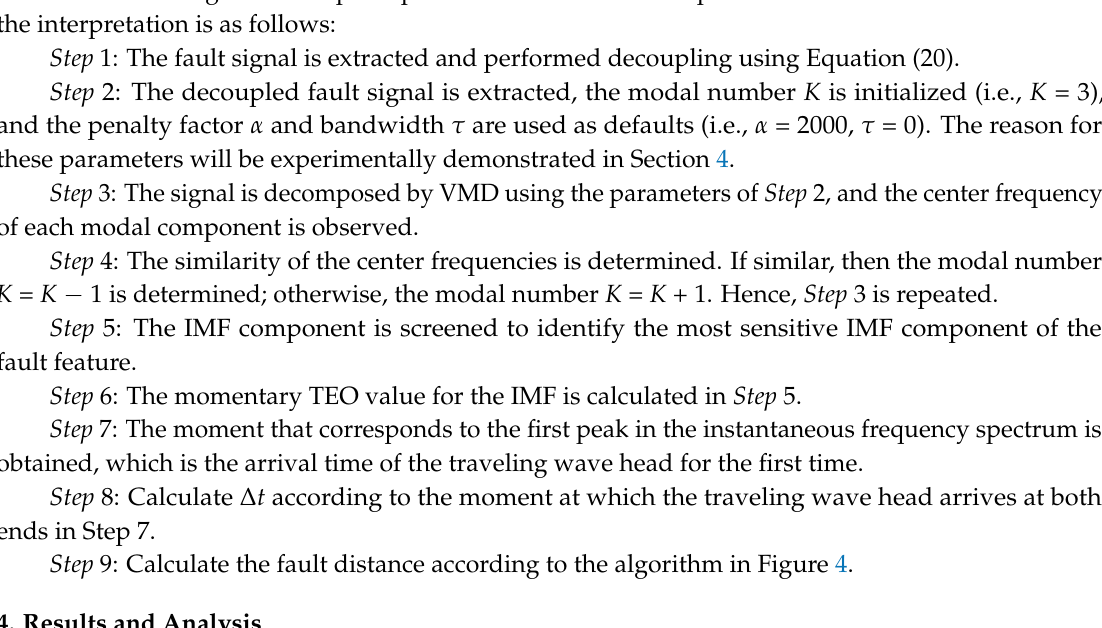
Figure 4. Algorithm for fault location of a two-segment line.